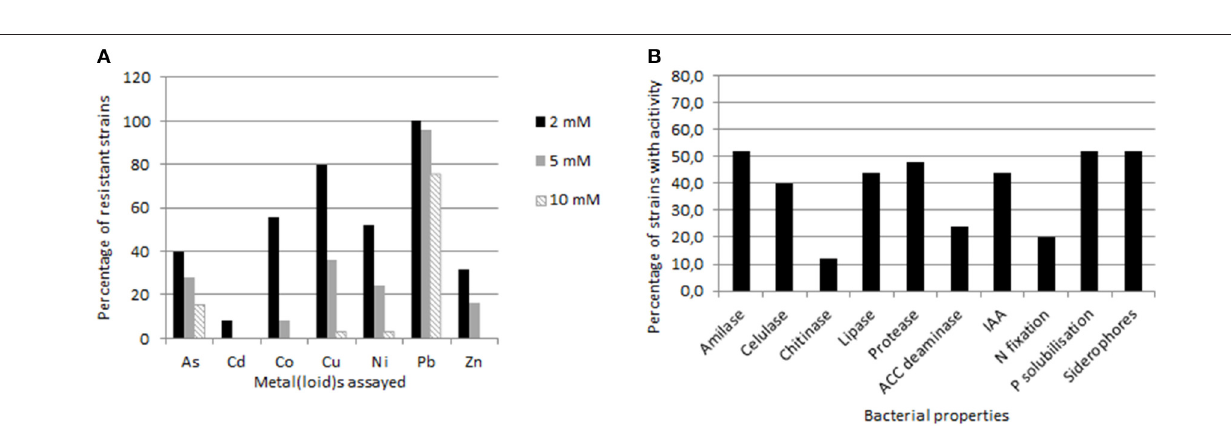
with ACC and later gave false positives results. Seven